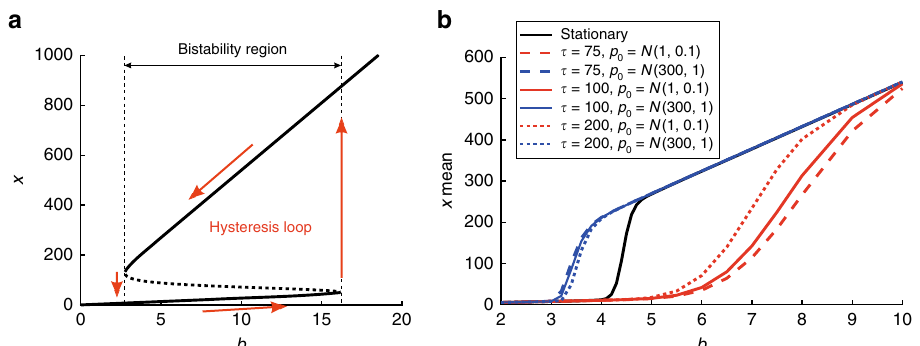
Fig. 1 Hysteresis in deterministic vs stochastic descriptions. a Hysteresis loop of the deterministic self-regulatory system (positive roots of Eq. (5)). For values of the control parameter b below a given threshold, there is a unique stable steady state of low protein x toward which the system evolves independently of the initial conditions. For input signals above a second threshold, the system evolves toward a unique stable steady state of high x . For signal values within both thresholds, the system is bistable, and evolves toward one stable state or another depending on the initial conditions. In the bistability region, enclosed by two saddle-node bifurcations, three different steady states coexist for a given b (stable and unstable branches are depicted using solid and dotted lines, respectively). b Transient hysteresis in the stochastic self-regulatory system: slow transients lead to multiple mean states leading to a transitory hysteretic behavior. Red and blue lines are transient solutions obtained from two different initial conditions in the form of Gaussian distributions Nð μ ; σ Þ with mean μ and standard deviation σ . When the system achieves the stationary state (black solid line corresponds to the stationary solution of the PIDE model), there is a unique mean x -value for given b (hysteresis disappears). As time increases, the solution gets closer to the stationary distribution. Simulations have been carried out in SELANSI